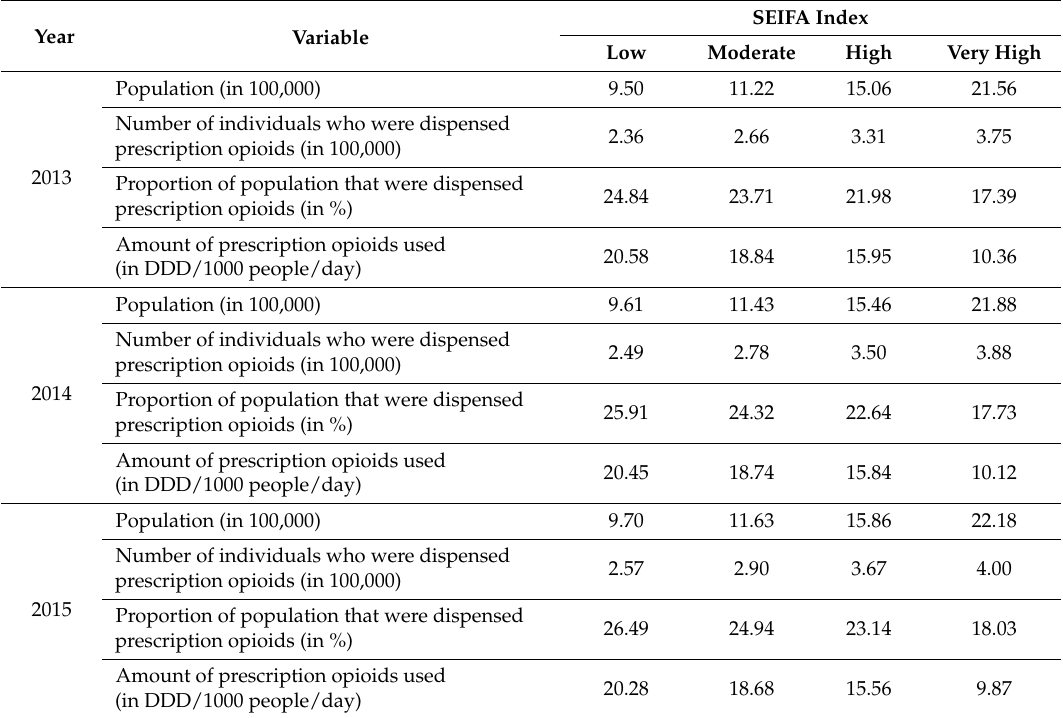
Table 3. Opioid dispensing during 2013–2015 across four levels of Socio-Economic Indexes for Areas